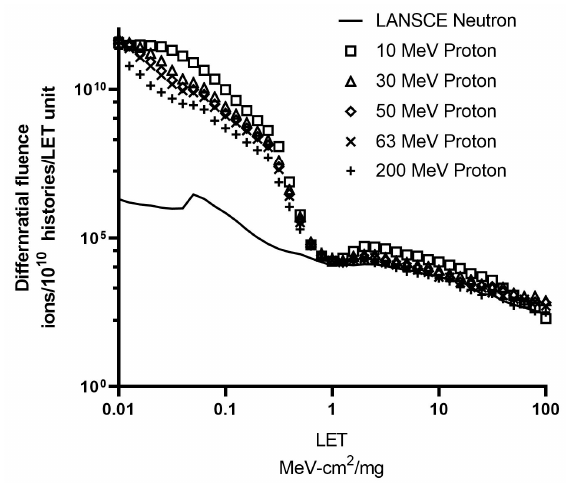
Figure 5. LET spectra in a structure without SiGe from 10, 30, 50, 63, and 200 MeV protons and LANSCE neutron.